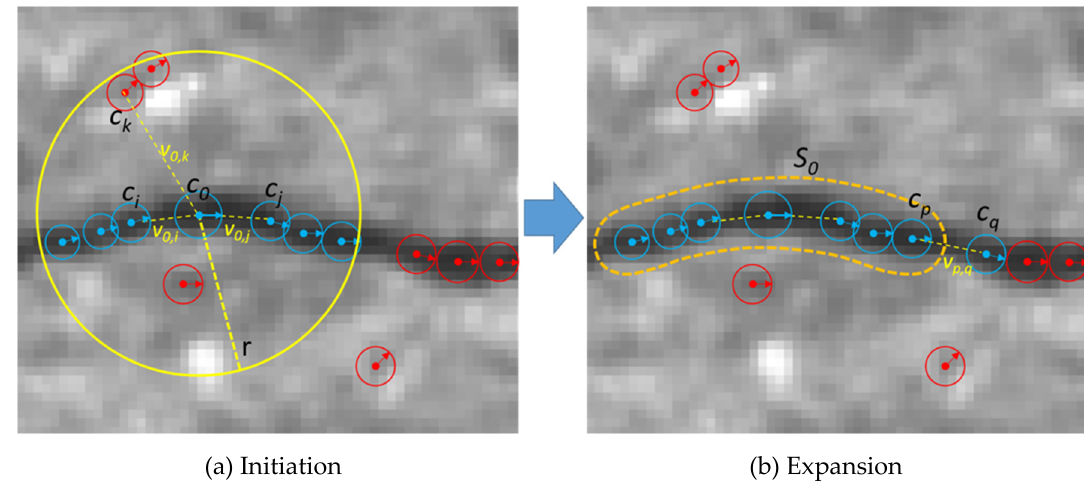
Figure 9. Crack segment generation.